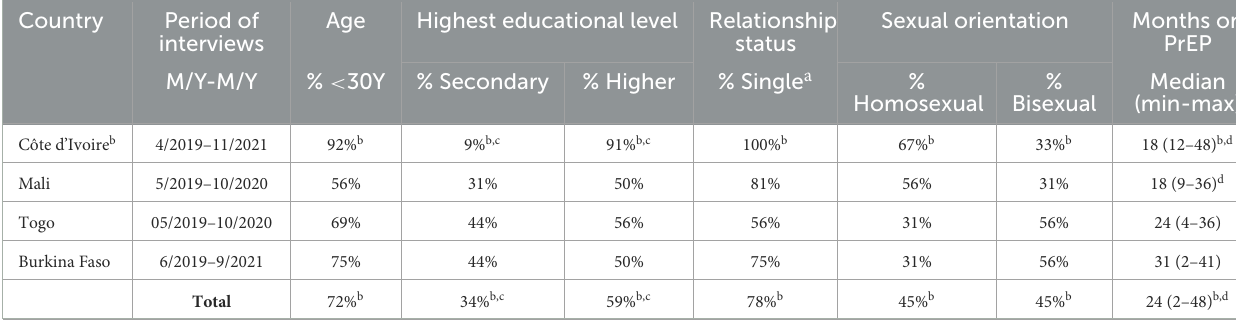
TABLE 2 Interviews with MSM taking PrEP ( n = 64, 16 per country).